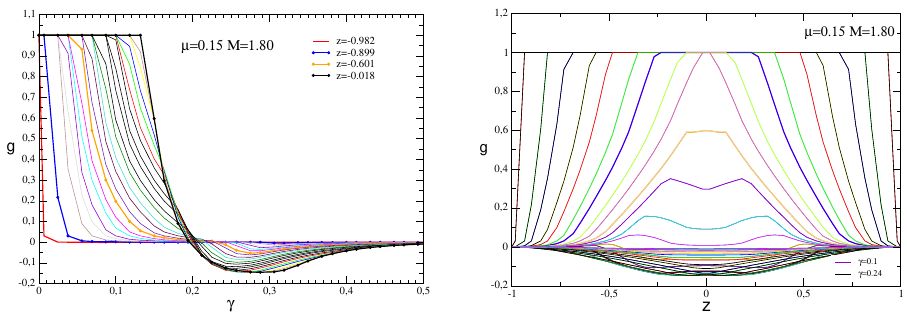
Figure 3. Nakanishi weight function g ( γ, z ) corresponding m = 1, µ = 0 . 15, B = 0 . 2 and α = 2 . 1 as a function of γ for a fixed z (left panel) and as a function of z for a fixed γ (right